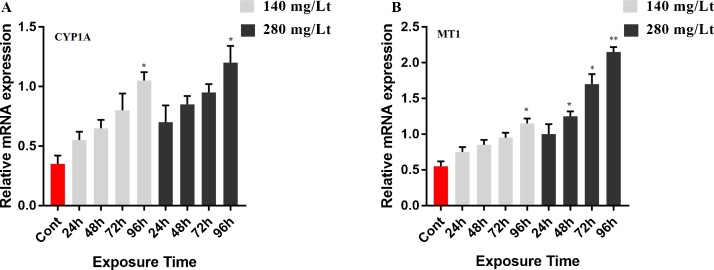
Effect of 140 mg/L and 280 mg/L doses of IMI exposure on mRNA transcript levels of CYP1A and MT1 in the brain of Common Carp. Values represent the mean ± SD of 3 indipendent samples; error bars indicate standard deviation. Statistical significance (* P ˂ 0.05, ** p < 0.01) was analyzed using a factorial ANOVA. A) Represent the relative mRNA expression levels of CYP1A. B) Represent the relative mRNA expression levels of MT1.